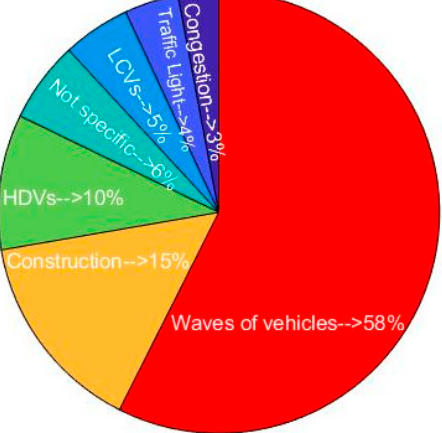
Figure 9. Potential reason for occurrence of elevated exposures.